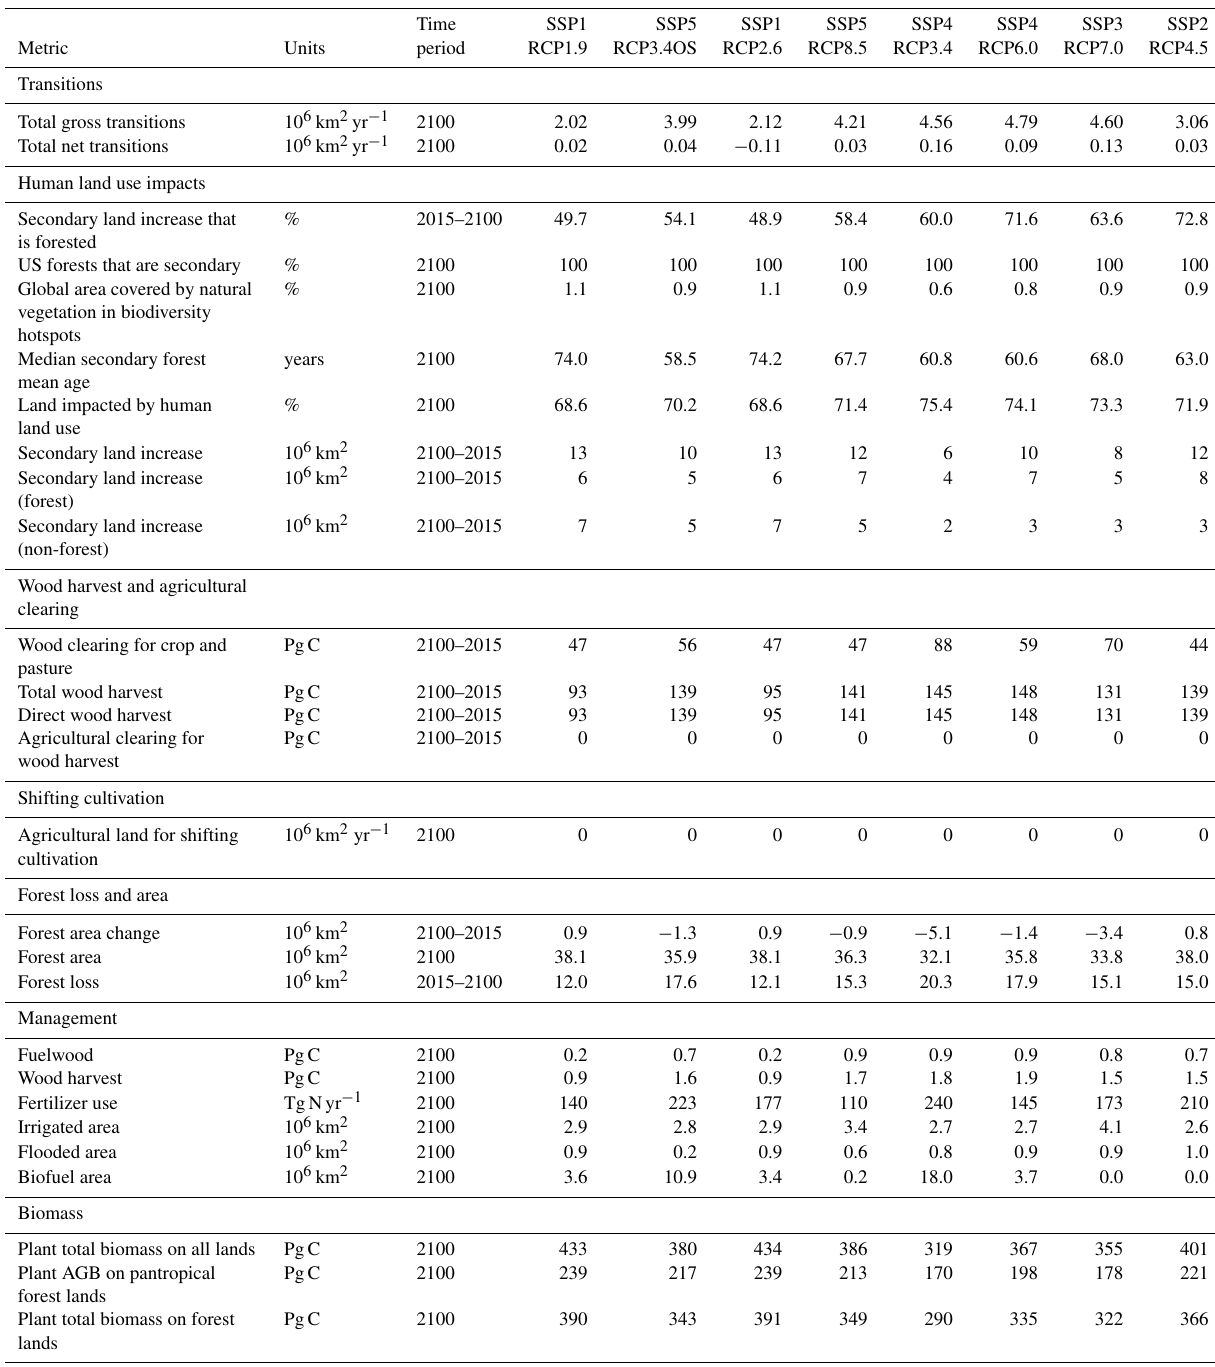
Table 5. Diagnostic table of future land